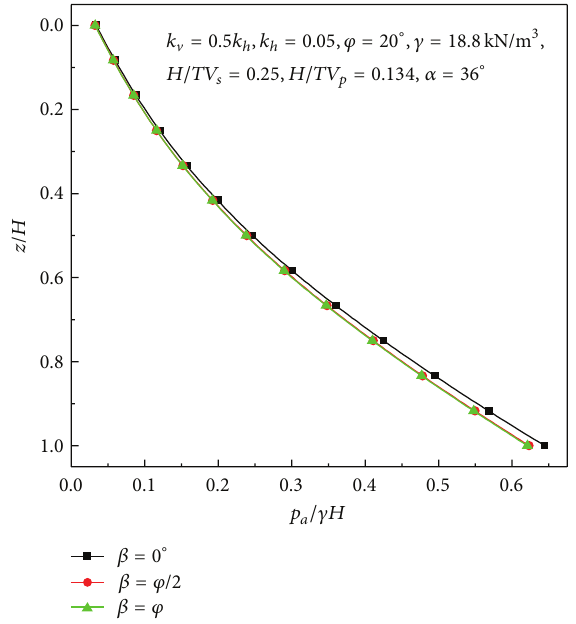
Figure 9: Active earth pressure distribution for different values of wall friction angle, 𝛽 .